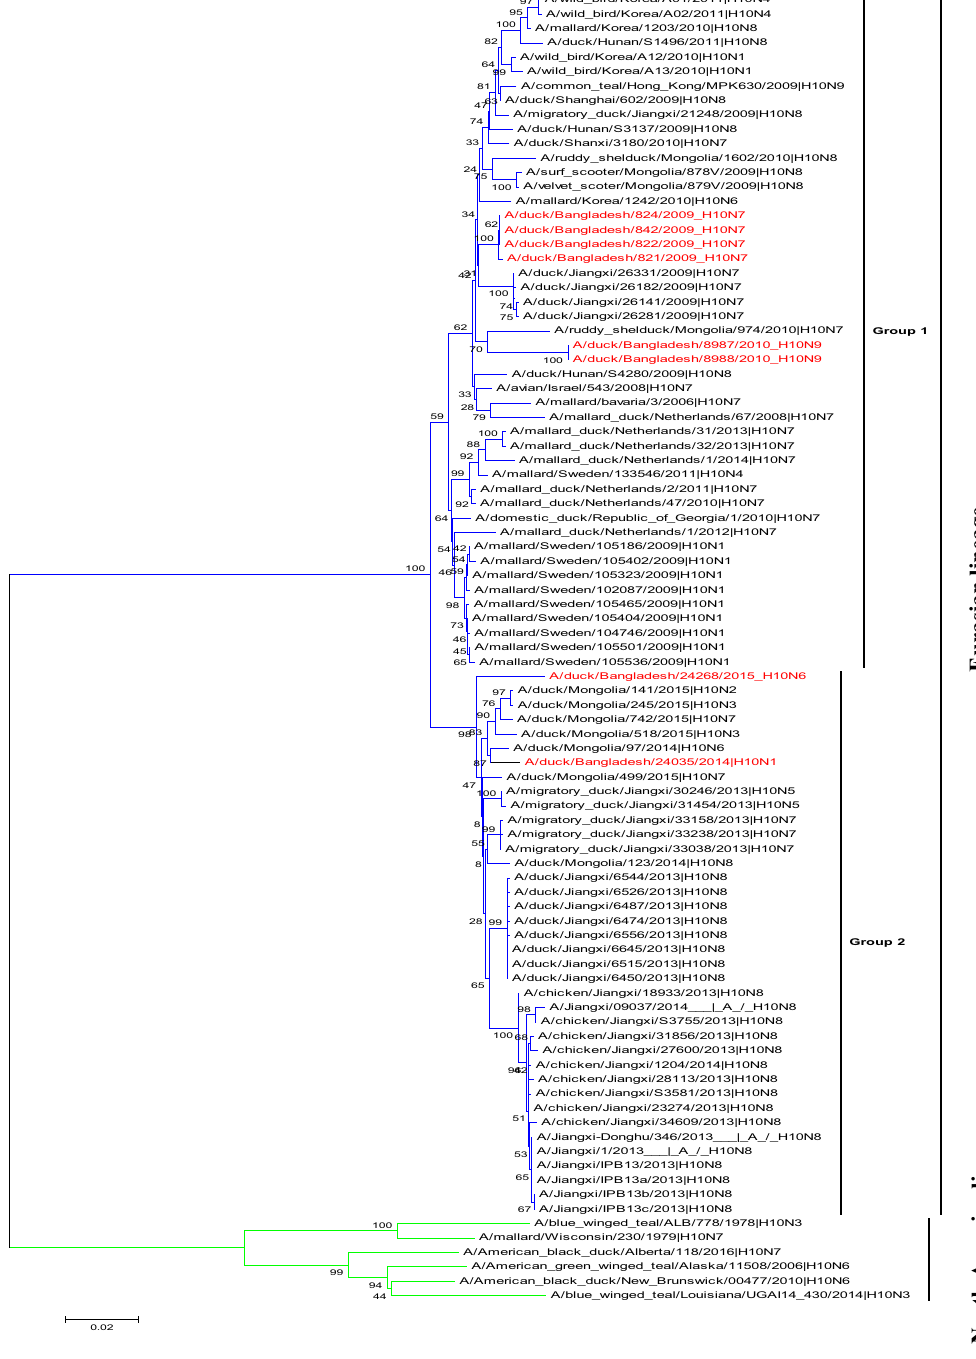
Figure 1. Phylogenetic trees for the HA gene of AIVs isolated from LPMs in Bangladesh. Phylogenetic analysis was performed with the neighbor-joining algorithm and the Kimura 2-parameter model. The reliability of the phylogenetic inference at each branch node was estimated by the bootstrap method with 1,000 replications. Evolutionary analyses were conducted with MEGA6 software. The H10 AIVs isolated during the surveillance period are denoted in red